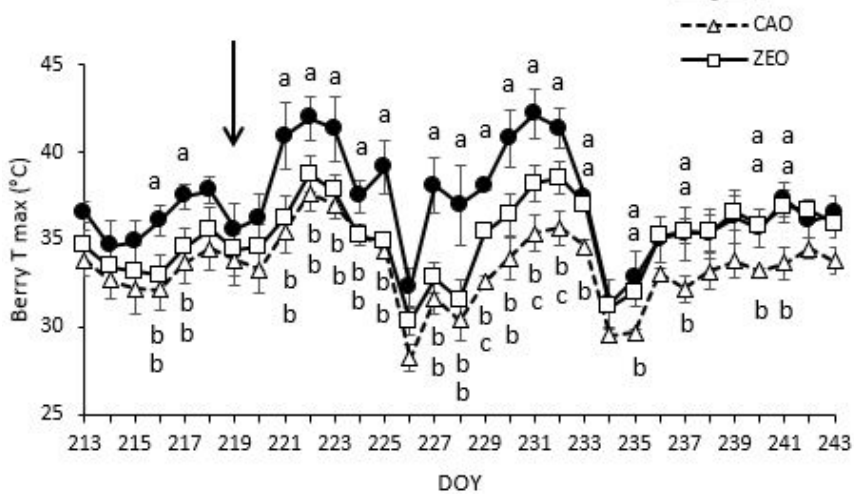
Figure 1. Trend of berry temperature (berry Tmax ◦ C) measured using thermo probes in August 2019. The values are presented as mean ± standard error (SE) (n = 8 per treatment). Different letters indicate significant differences between treatments according to the Tukey test ( p ≤ 0.05). The arrow indicates the date of the second treatment with the mineral particles. The same thermal drop was recorded on the grapes treated with ZEO with a substantial difference as regards the persistence of the mineral coating on the berries. While, in 2019, the maximum berry temperature was affected by ZEO for 18 continuous days, in 2020, the cooling effect was reduced to one week. Overall, the maximum temperatures were always higher in the C group while ripening during several heatwaves when values of approximately 40 °C were reached in both years. In particular, the maximum temperatures of the berries recorded for CAO and ZEO were consistently below the thermal limit of 35 °C in 2019 and only for eight days in 2020. Figure 2. Trend of berry temperature (berry Tmax °C) measured using thermo probes in August 2020. The values are presented as mean ± SE (n = 8 per treatment). Different letters indicate